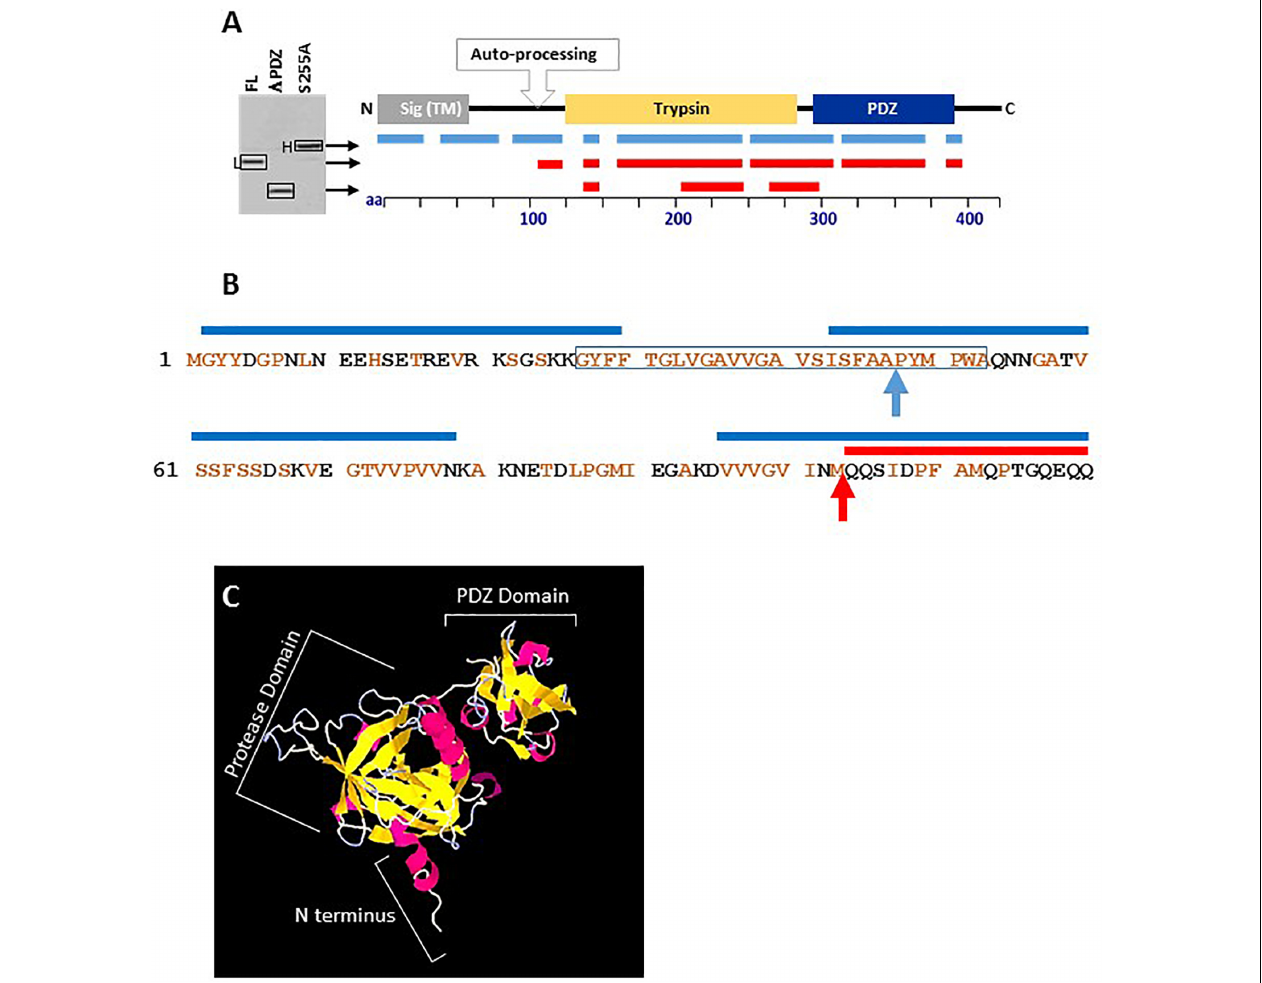
FIGURE 3 | Liquid chromatography mass spectrometry (LC-MS) mapping of the heavy S255A (unprocessed), the light FL (auto-processed) and the truncated (cid:49) PDZ forms of HtrA BA . (A) The lines under the schematic linear depiction of HtrA BA describe the position of the peptides detected by LC-MS in the respective forms of HtrA BA collected from the SDS-gel as indicated by arrows. Positions of peptides obtained from digestion of the H form are indicated in blue while those from the L form or the (cid:49) PDZ form are in red. (B) The amino-acid sequence of the first 120 residues of HtrA BA . Brown residues are hydrophobic. The blue lines above the sequence indicate peptides identified by LC-MS in the heavy (H) form of HtrA BA S255A. The red line above the sequence indicates the first peptide identified by LC-MS in the light (L) form of HtrA BA . The highly hydrophobic trans -membrane domain is framed. The blue arrow indicates the predicted site of signal peptide cleavage. The red arrow indicates the predicted site of proteolytic auto-processing. (C) High confidence 3D structural modeling of HtrA BA (created by using PHYRE Protein Fold Recognition modeling, Kelley et al., 2015) showing the clear spatial separation of the indicated protease and PDZ domains of the protein and that its first 100 amino acids constitute an exposed protruding domain (marked as N terminus), highly accessible to proteolysis without affecting the general architecture of the